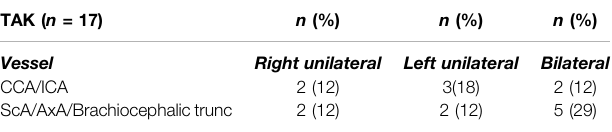
TABLE 3 | Occurrence of signi fi cant stenosis and occlusions important for judgement of cerebral circulation (CCA, ICA) and brachial circulation (ScA, Axa, Brachiocephalic